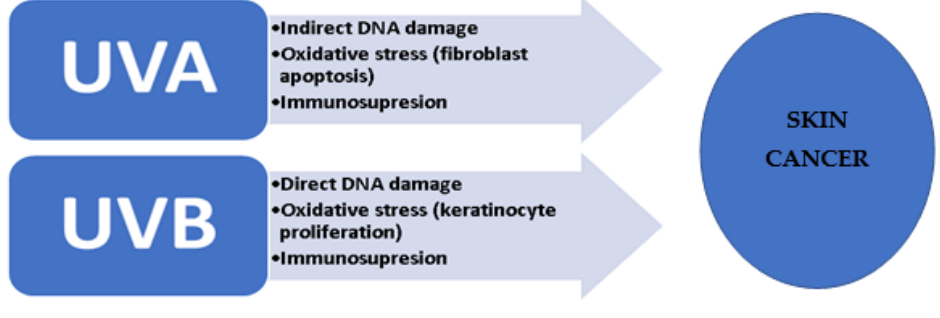
Figure 1. UV exposure and skin cancer .